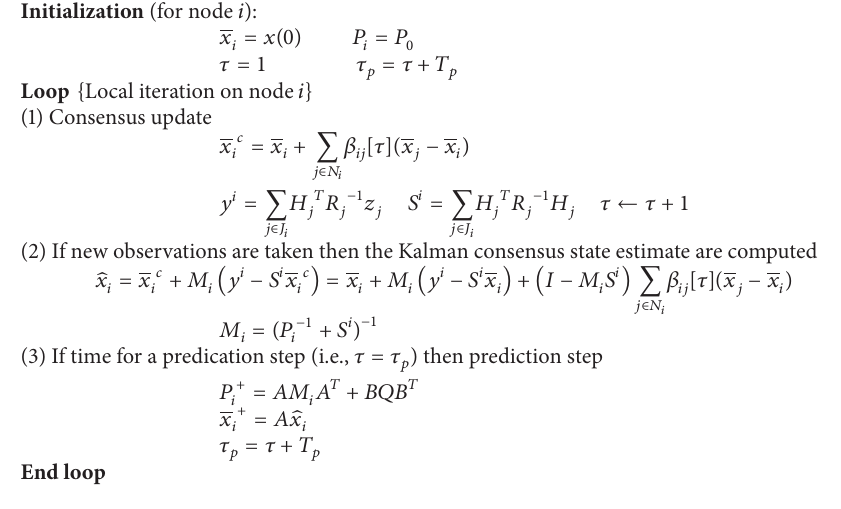
Algorithm 1: Kalman consensus filter.